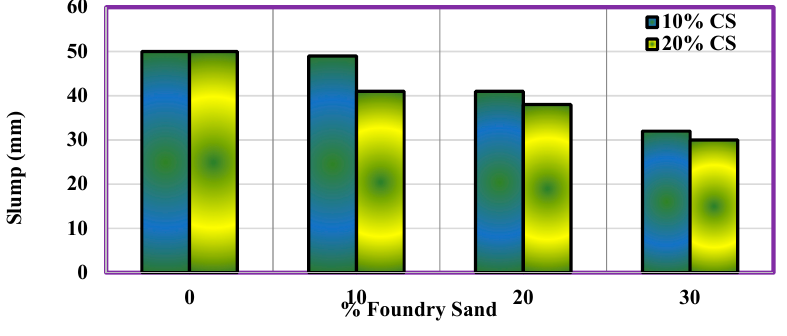
Figure 8. Slump test results. Table 8. Chemical properties of foundry sand.